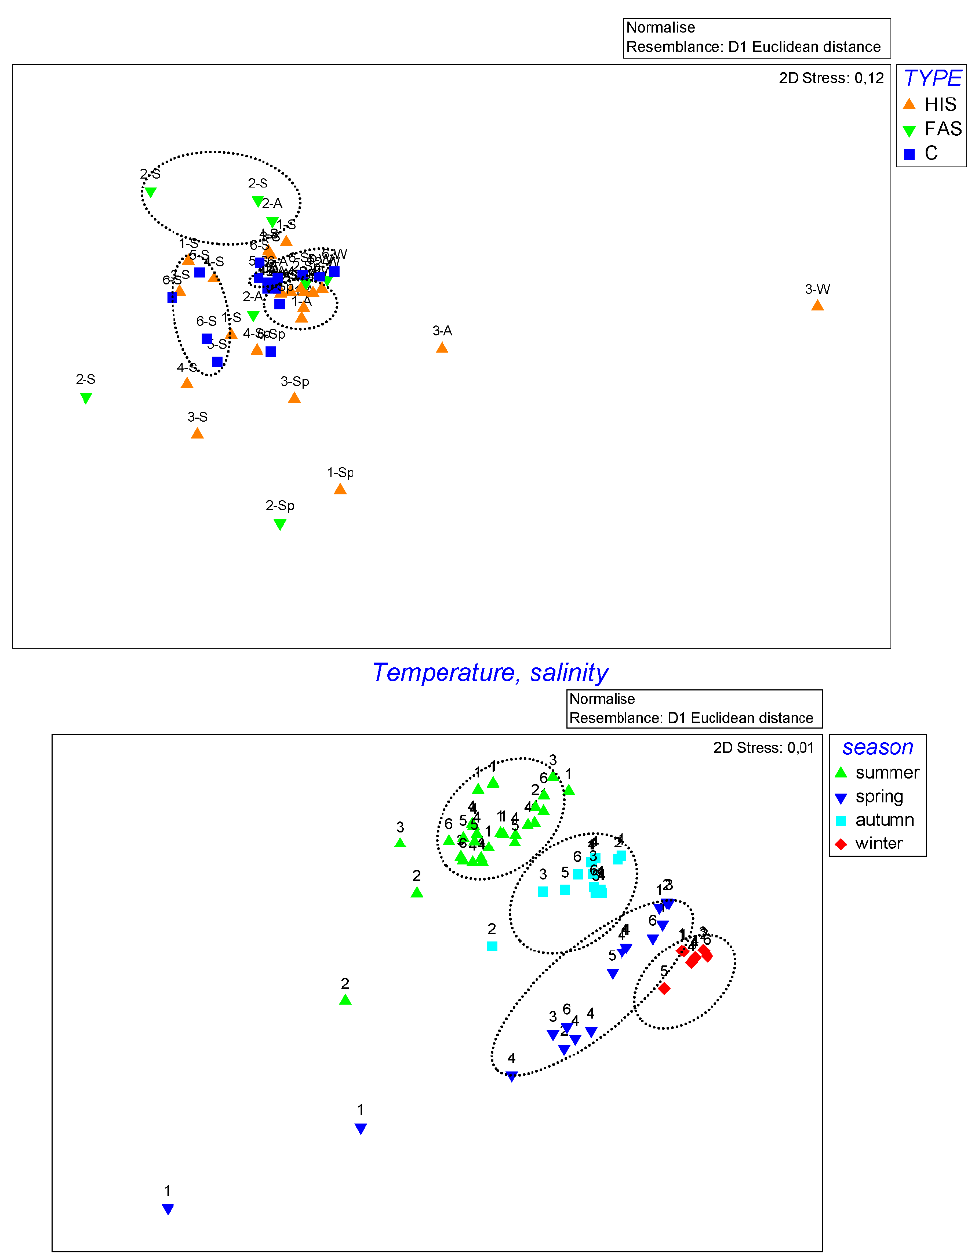
Figure 2. Multi-Dimensional Scaling (MDS) analysis computed on physical–chemical parameters ( above ) and on T and S data ( below ).